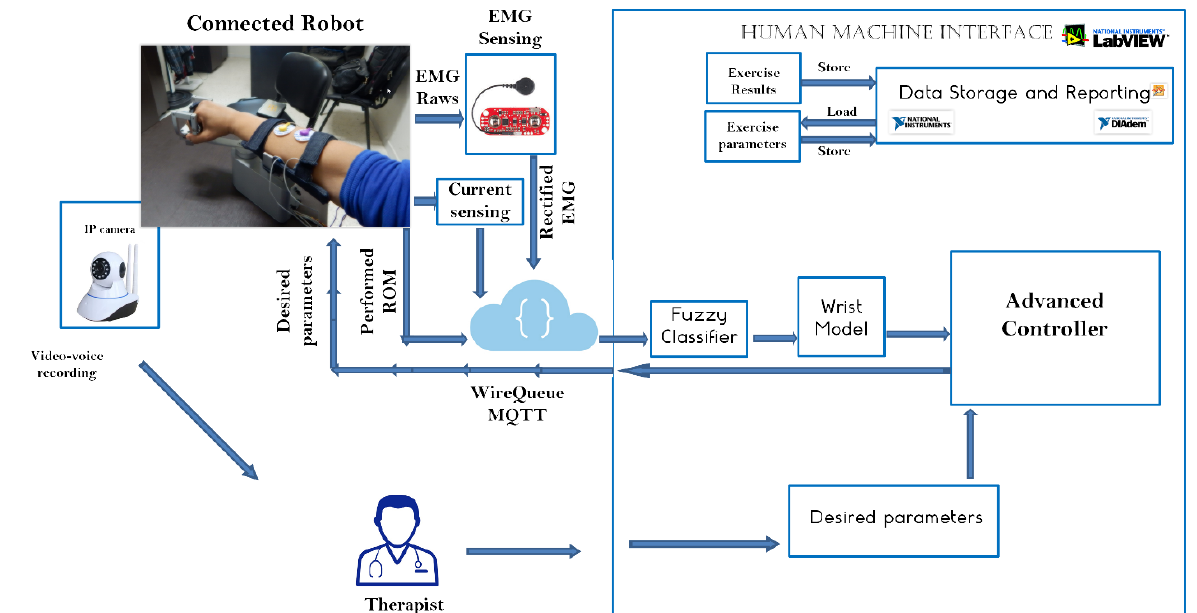
Figure 5. Control architecture overview.